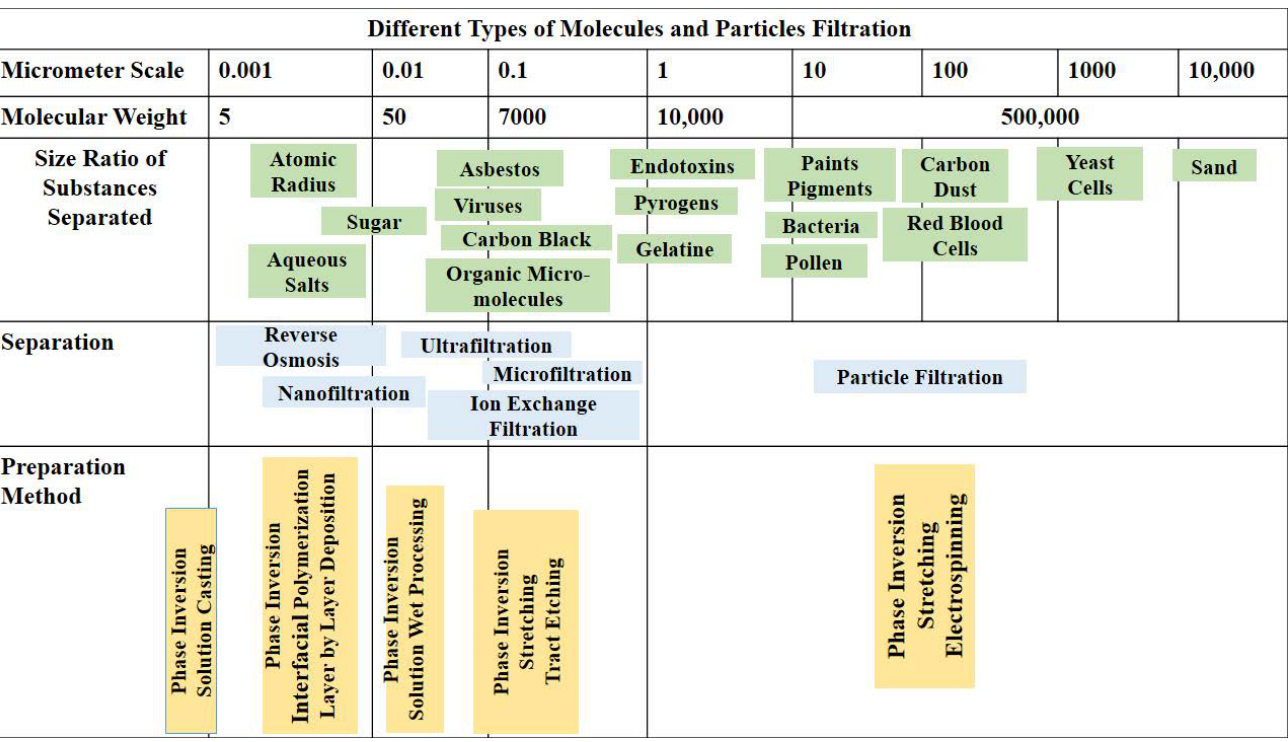
Figure 1. Different types of molecule and particle